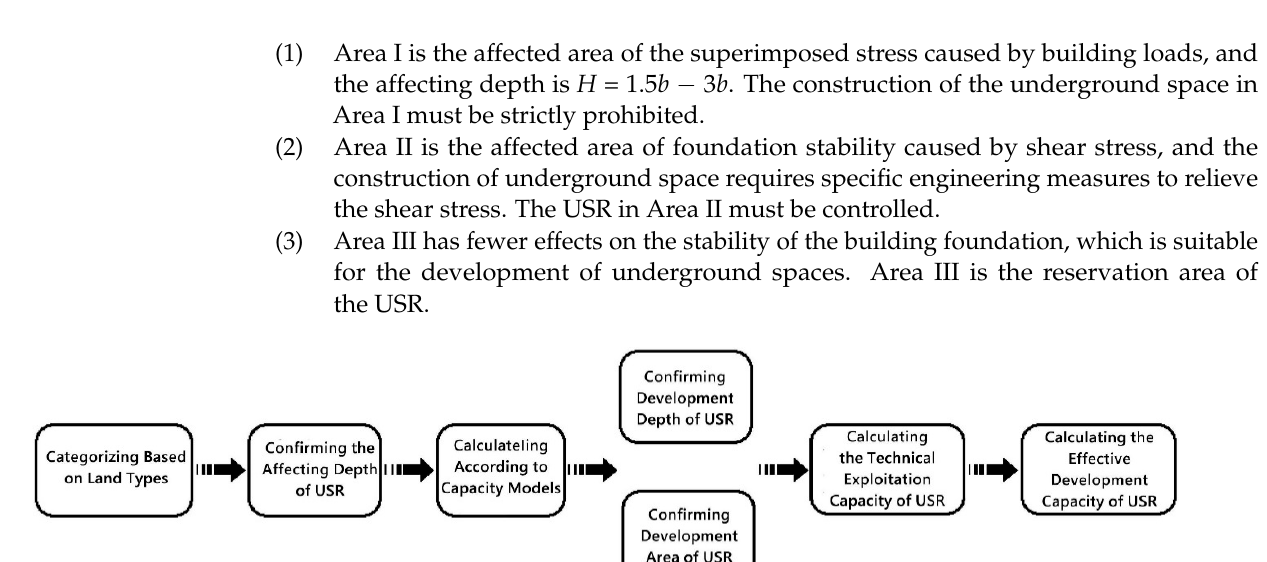
Figure 8. Subordination and inclusion relation of USR.